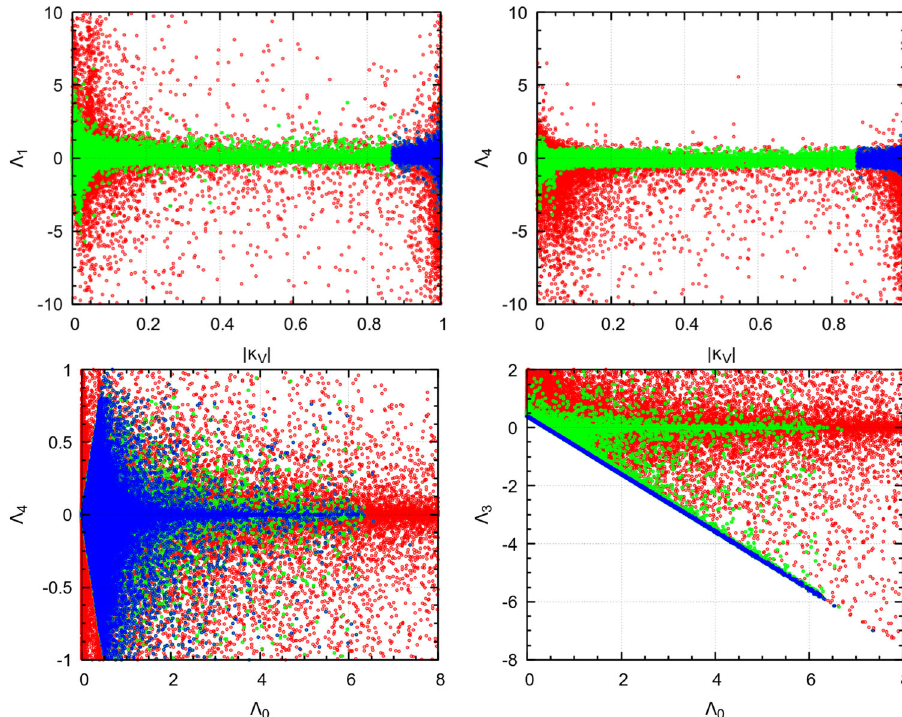
Fig. 4 Left panel: Relation between κ V and (cid:4) 1 . Right panel: Relation between κ V and (cid:4) 4 . Color conventions: No cuts (red), with theoretical cuts (green), and after the κ V constraint (blue)